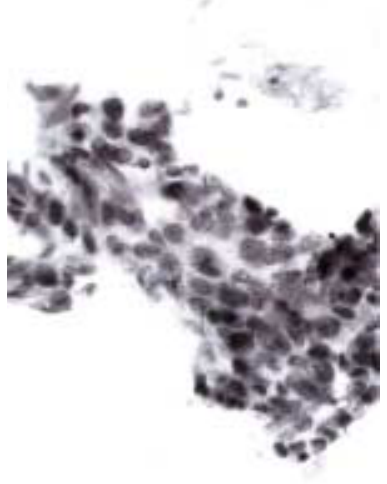
Fig. 2. Cluster of exfoliated coherent cells from an early squa- mous cell carcinoma of the tongue revealing hyperchromatic small but polymorphic nuclei with enlarged nuclear–cytoplasmic ratio and prominent nucleoli. Patient A. Primary magnification 630 × .